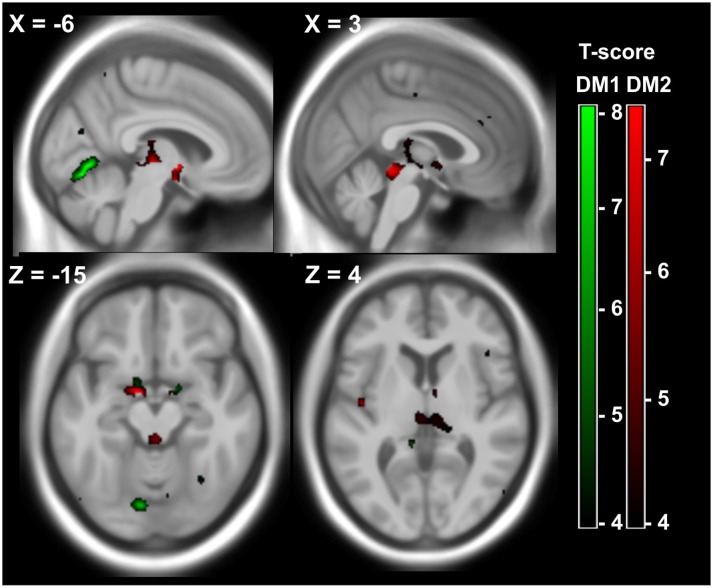
Flexibility of thinking and brain GM.Areas of significant negative correlations between GM volume and flexibility of thinking (RWT semantic verbal fluency with change of categories) in 12 DM1 patients (green) and 15 DM2 patients (red). Voxelwise multiple regression analysis with the test outcome (pathologic / normal) and age as covariates. Age was used as a covariate of no interest. Areas with adjusted p at cluster level < 0.05 after FWE correction are shown; X,Y,Z: MNI-coordinates: negative X-values reflect left side and positive X-values right sided location.